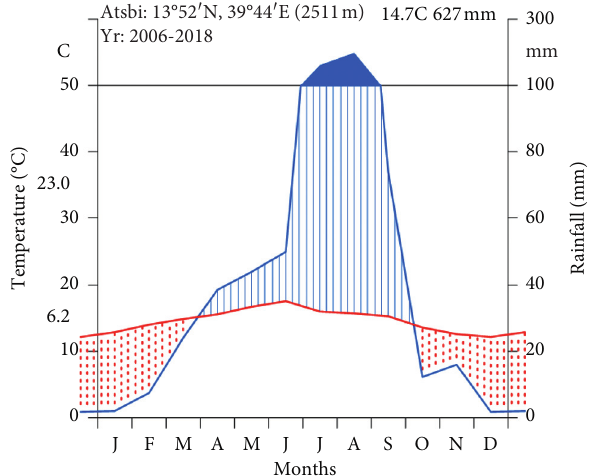
Figure 2: Mean monthly rainfall (mm) and temperature ( °